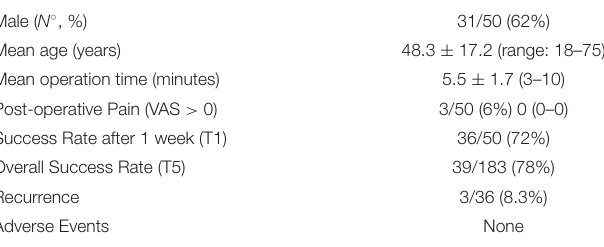
TABLE 1 | Patient characteristics and procedural results. TABLE 2 | Differences among the mean of the Giamundo score at baseline (T0) and follow-up visits.